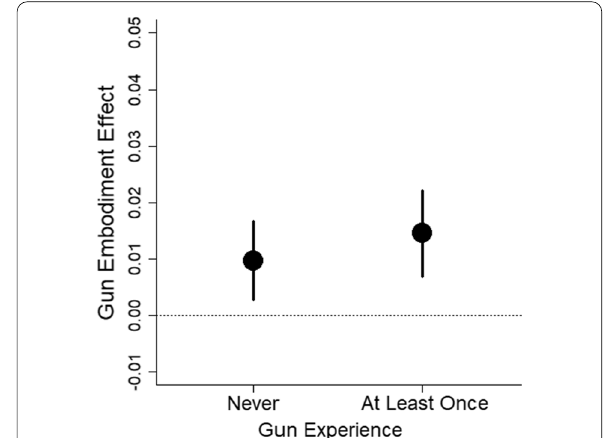
Fig. 11 Mean gun embodiment effect (measured with proportion of correct responses) is plotted as a function of prior gun experience. Error bars are 1 SEM